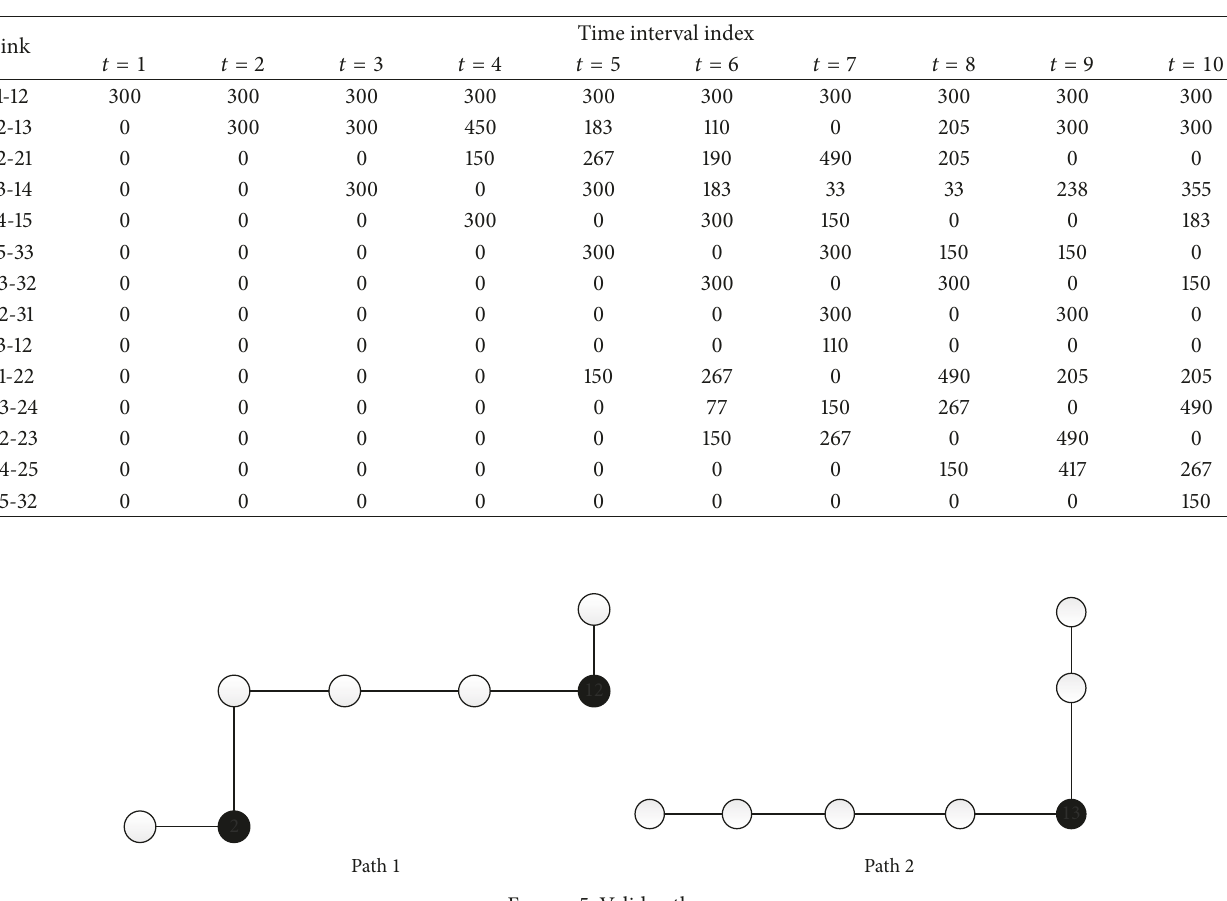
Table 2: The assigned passengers for directed links during each interval.